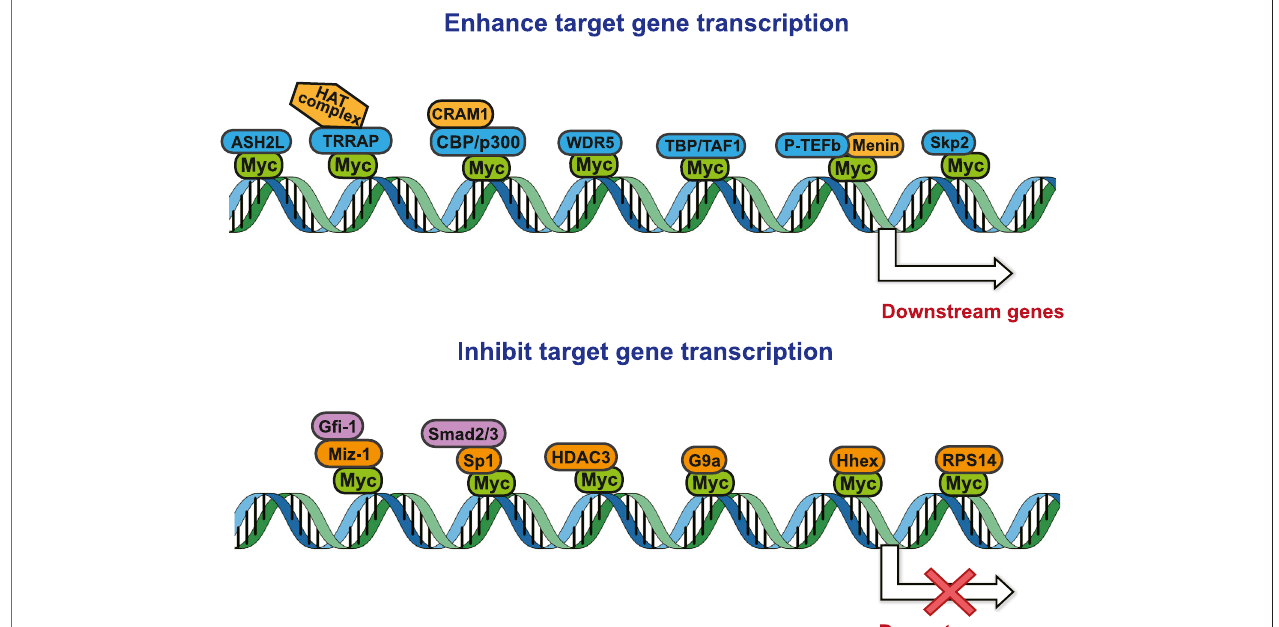
FIGURE 2 | Protein-protein interaction works on Myc transcriptional activation and